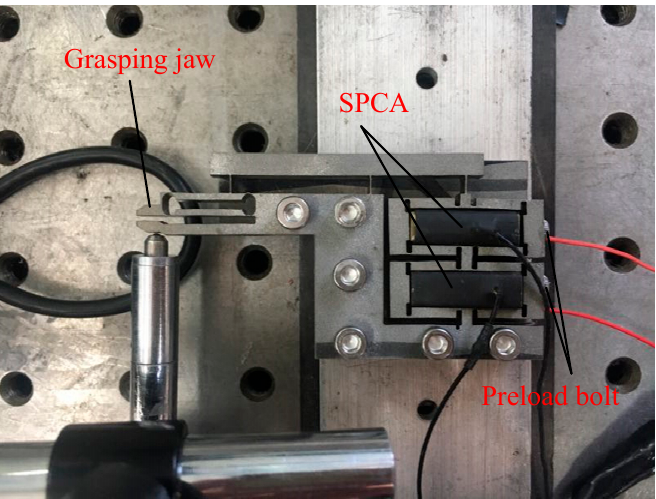
Figure 8. Physical model of the microgripper.